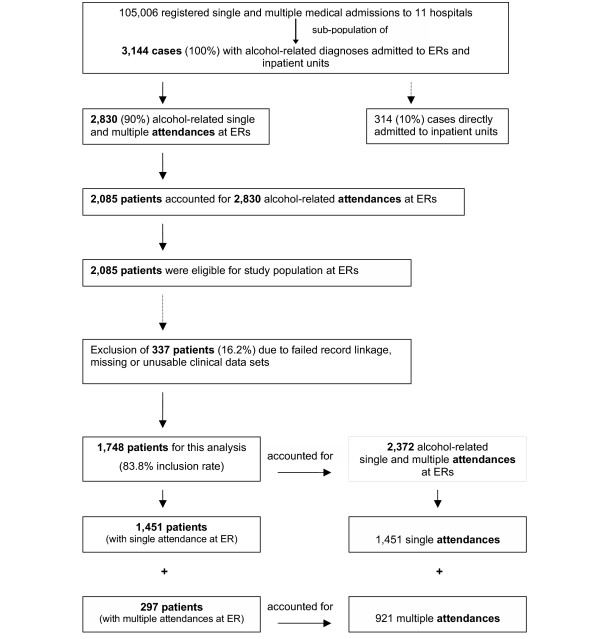
Sampling and study population.